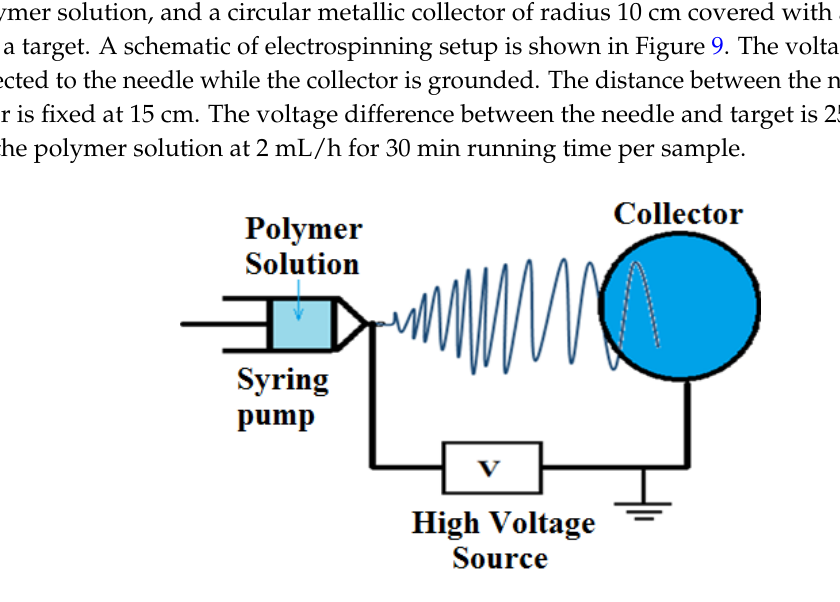
Figure 9. Schematic diagram of the electrospinning setup.